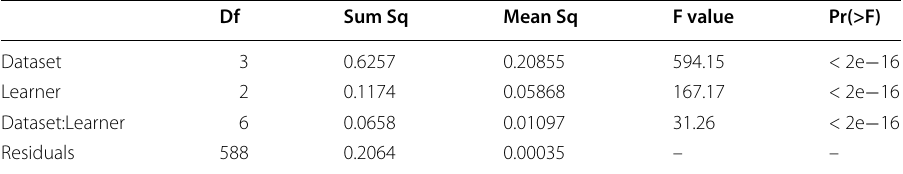
Table 12 Two-factor ANOVA test results Df Sum Sq Mean Sq F value Pr(>F) Dataset